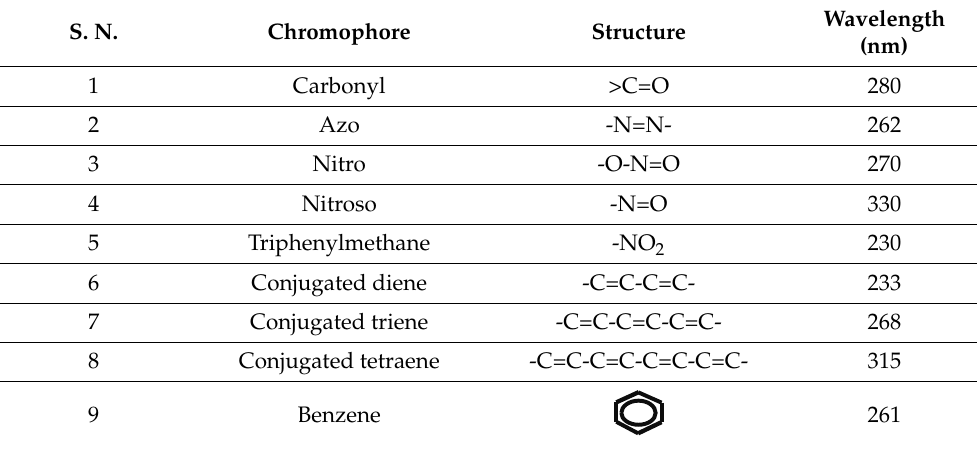
Table 1. The structure of chromophores.